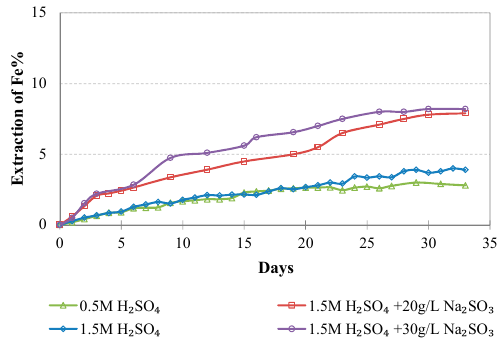
Figure 6. Evolution of % Co extraction vs time during LAI leaching for different tests.